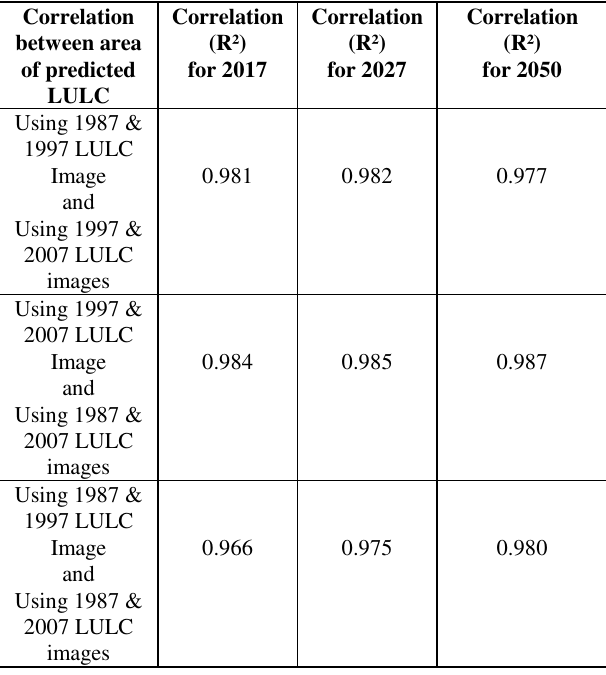
Table 5. Correlations of between area of predicted LULC